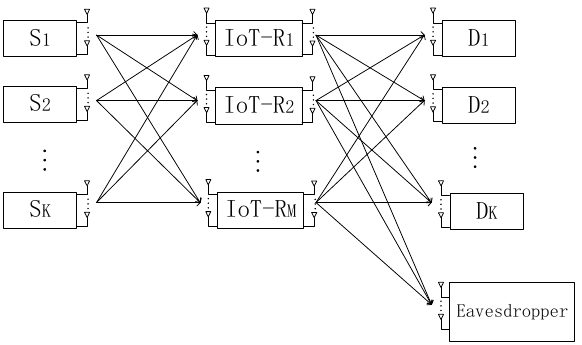
Figure 1. Two-hop multiple input multiple output (MIMO) interference relay system model in the wireless Internet of Things (IoT).